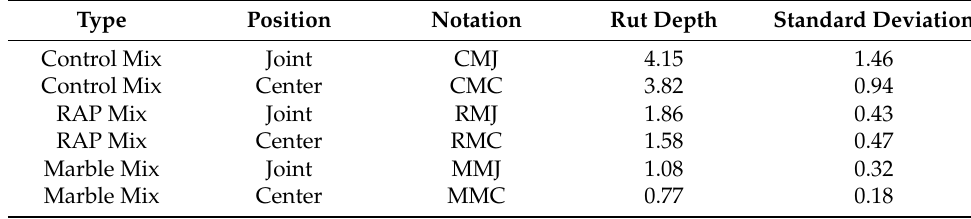
Table 7. Average Rut Depth